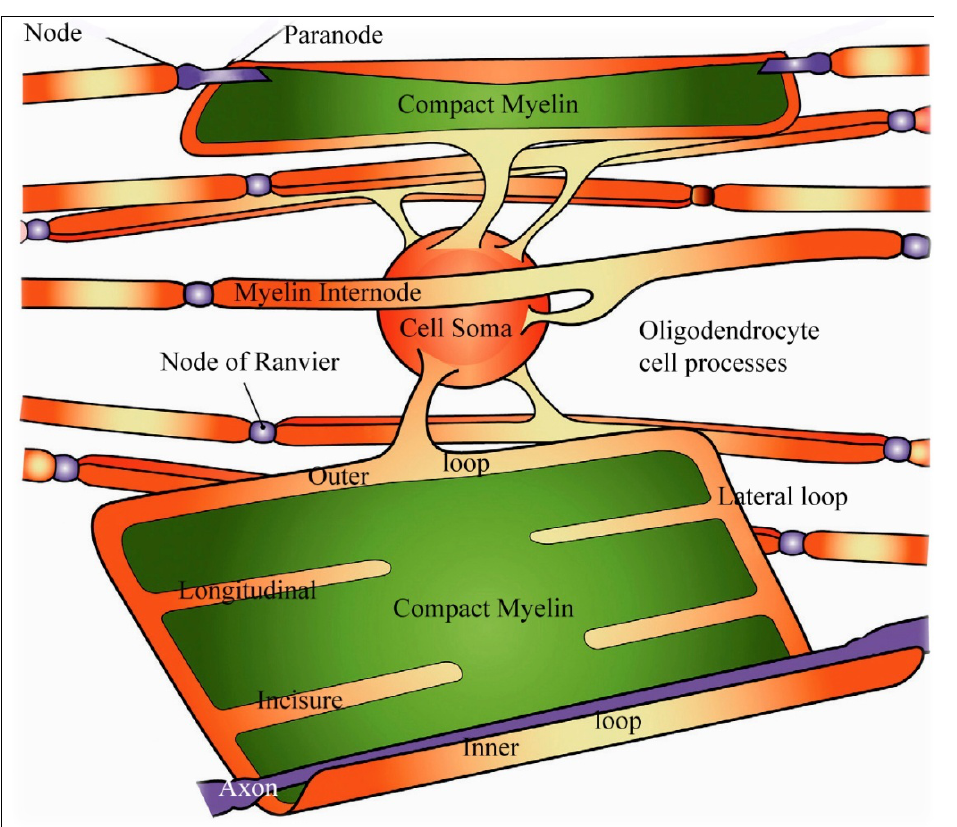
that cell. On the uppermost nerve fibre, the myelin sheath is partially unwrapped. In the lowest fiber the myelin sheath is shown completely unwrapped forming a flattened sheet with only the inner loop of the oligodendrocyte process juxtaposed to the axon (labelled axon in white). Channels containing small portions of oligodendrocyte cytoplasm are indicated in orange and form the paranodal/lateral loops, and the ad (inner loop) and abaxonal (outer loop) spaces and are all in continuity with each other. Extending from the paranodal/lateral loops into the compact myelin (in green) of the sheath are four schematic longitudinal incisures. Adapted from Aggarwal et al . 2011